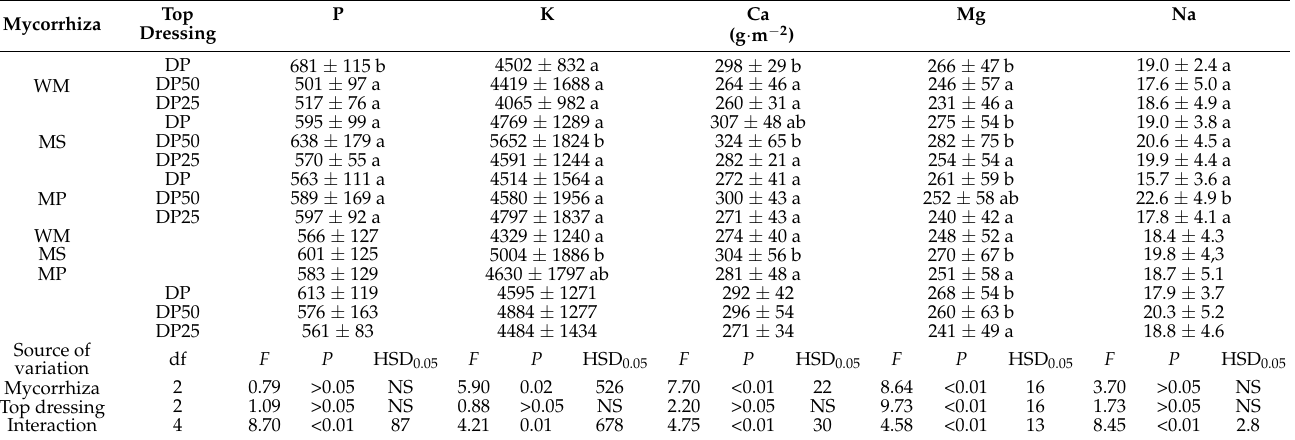
Table 5. The amount of macronutrients accumulated in the total yield of sweet pepper fruits; on average across three years